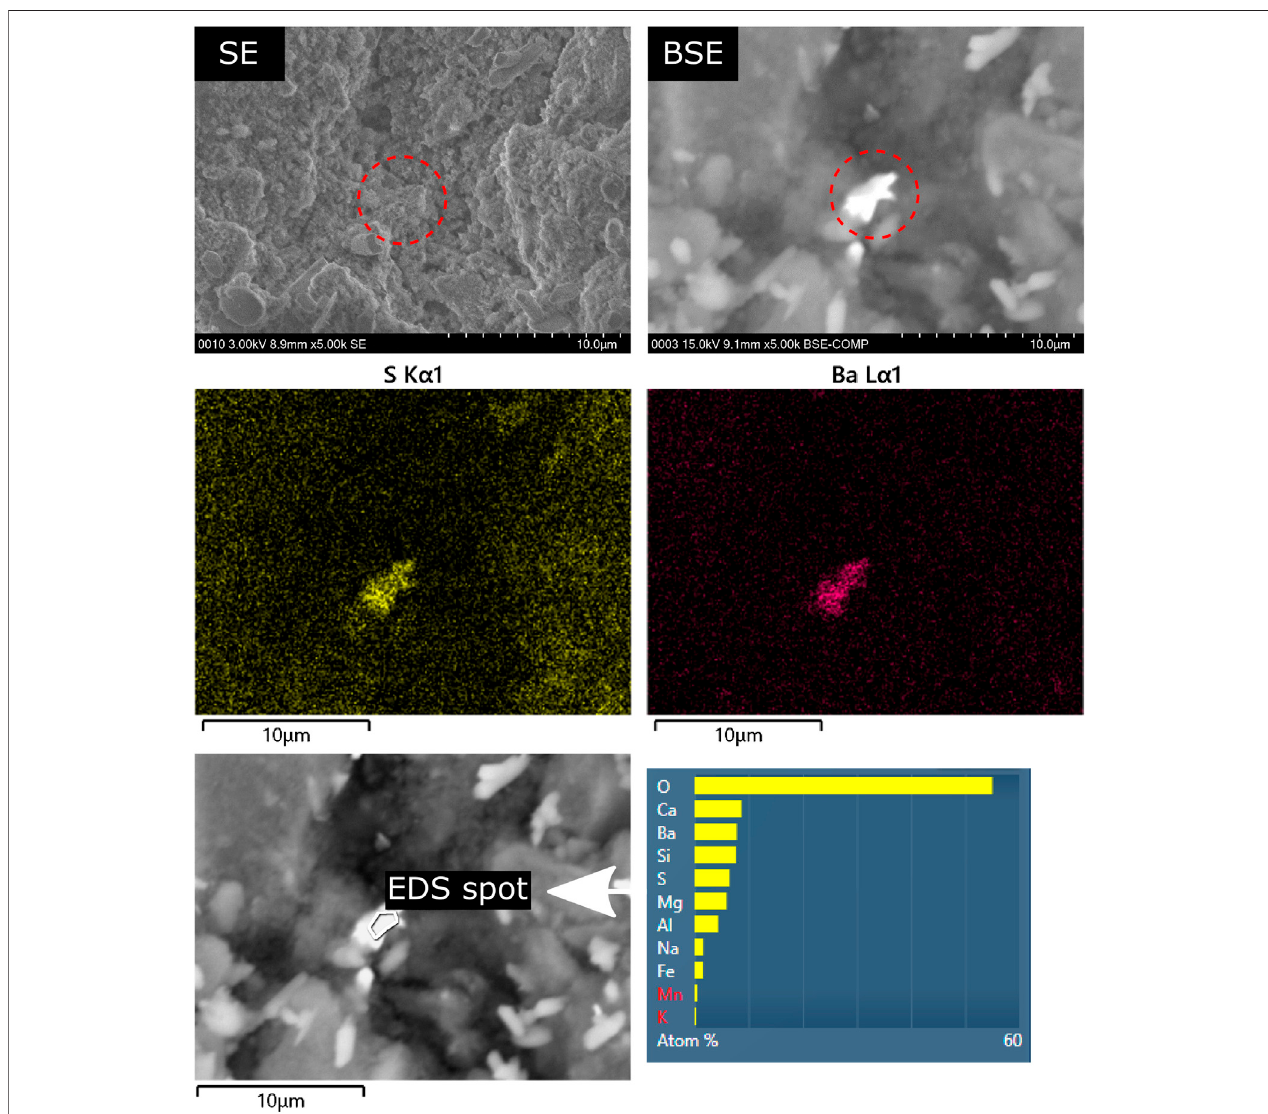
FIGURE 8 | BaSO 4 crystals near the outermost surface of a hardened binder paste with high GGBS content (65_SO4) following exposure to (30 gl − 1 SO 2 − 4 ), obstructedbyathinlayerofbinder.TheBaSO 4 crystalsareunlikelydryingartifactssincetheyarepartiallyorcompletelyincorporatedintheouterbinder.LowvoltageSE image of the surface and high voltage BSE image of the atomic weight contrast. EDS mappings of sulfur and barium reveal a local concentration maximum of these elements. EDS measurements showed about equal amounts of barium and